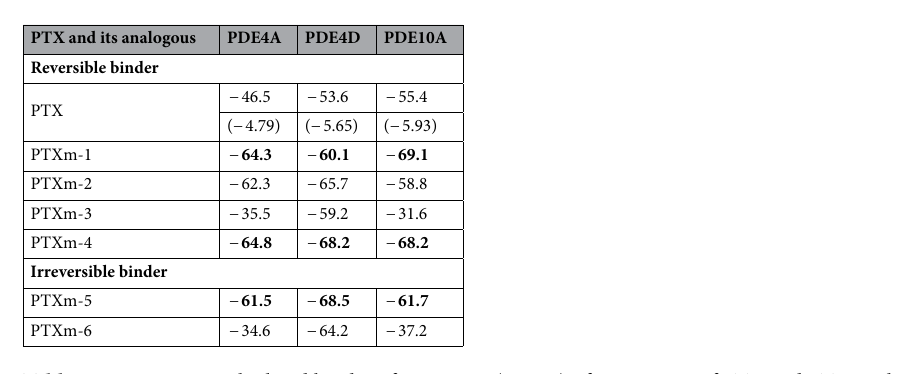
Table 1. MM-GBSA calculated binding free energy (ΔG bind ) of interaction of PTX and PTX analogues with PDEs, after 50 ns of MD simulation. Values in parenthesis are ΔG calculated by performing ITC binding studies. All the values are in kcal.mol −1